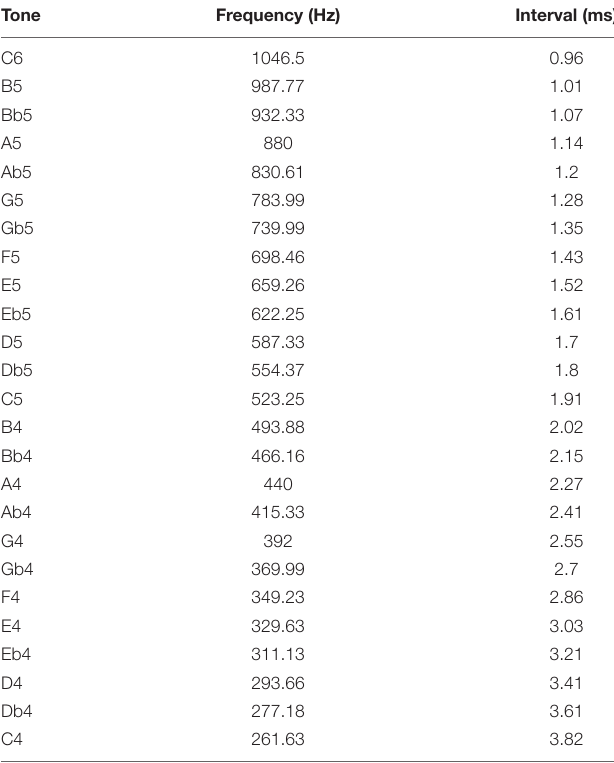
TABLE 1 | Annotated time interval durations referring to a 12-tone equal temperament relative to A4 (440